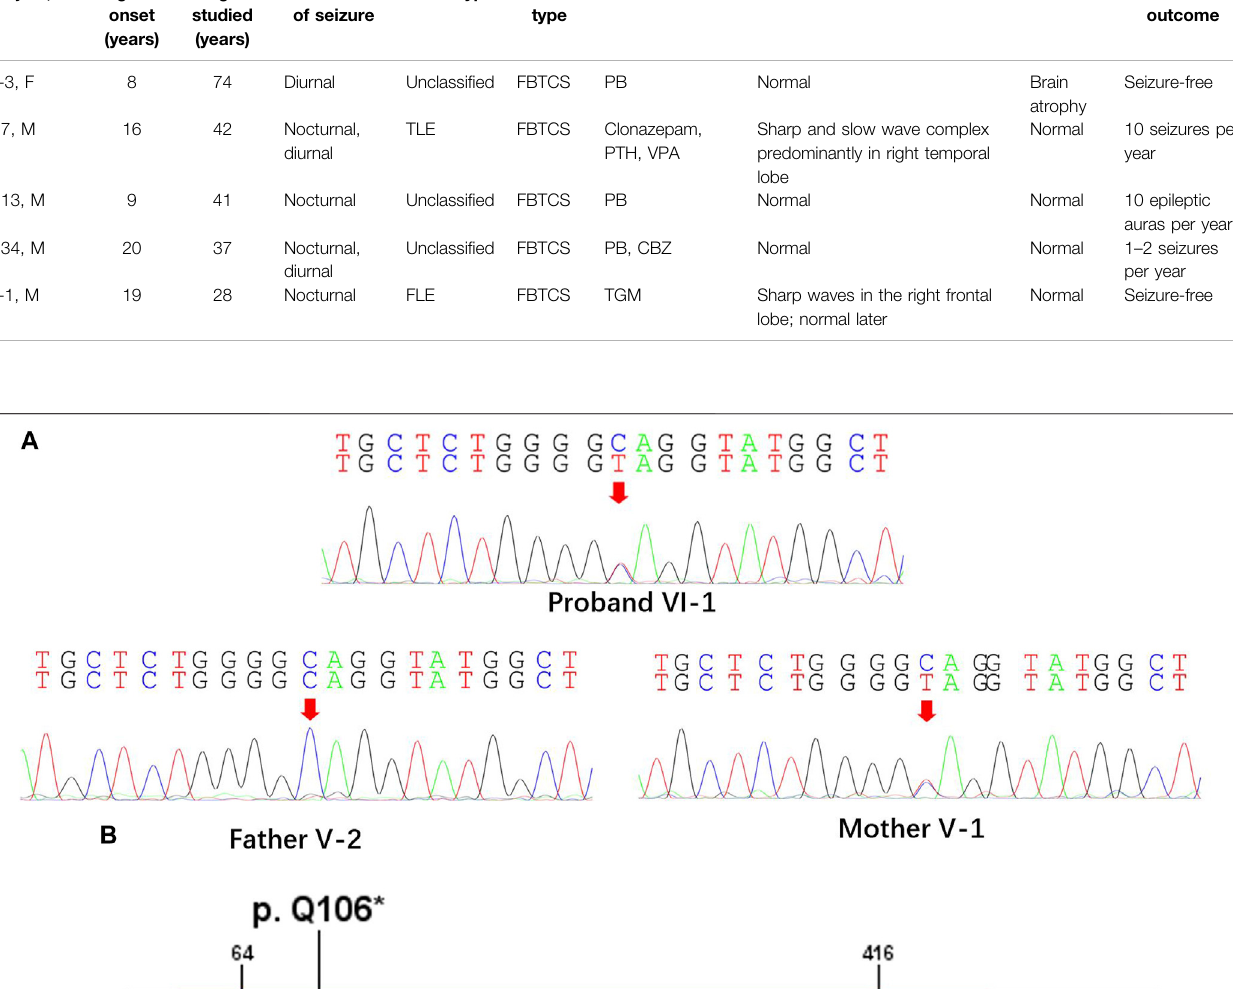
Frontiers in Genetics |